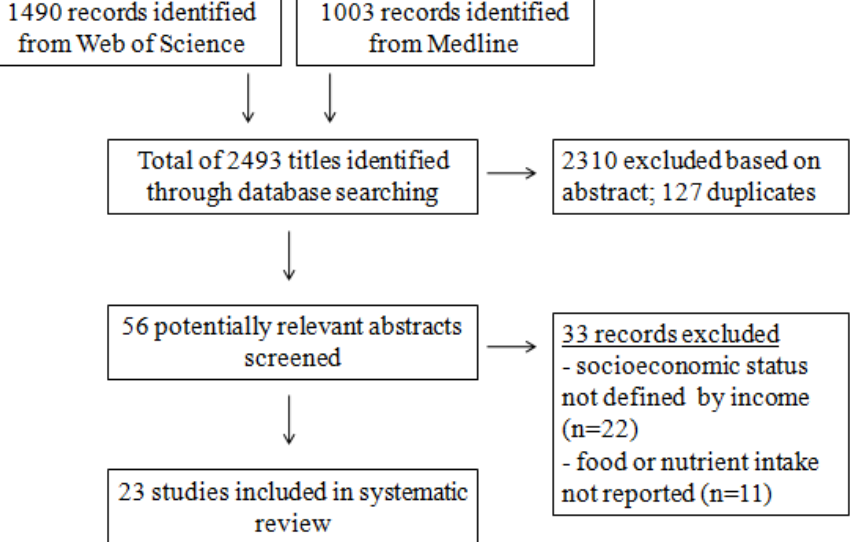
Figure 2. Flow diagram of literature search and study